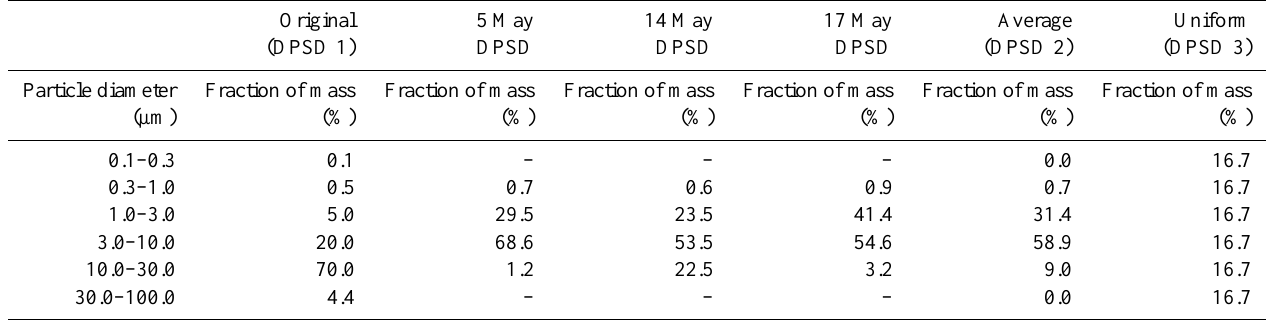
Table 1. Distal particle size distributions (DPSDs). DPSDs 1, 2 and 3 are used as input to the NAME model. Other DPSDs are derived from observations on 5, 14 and 17 May 2010.